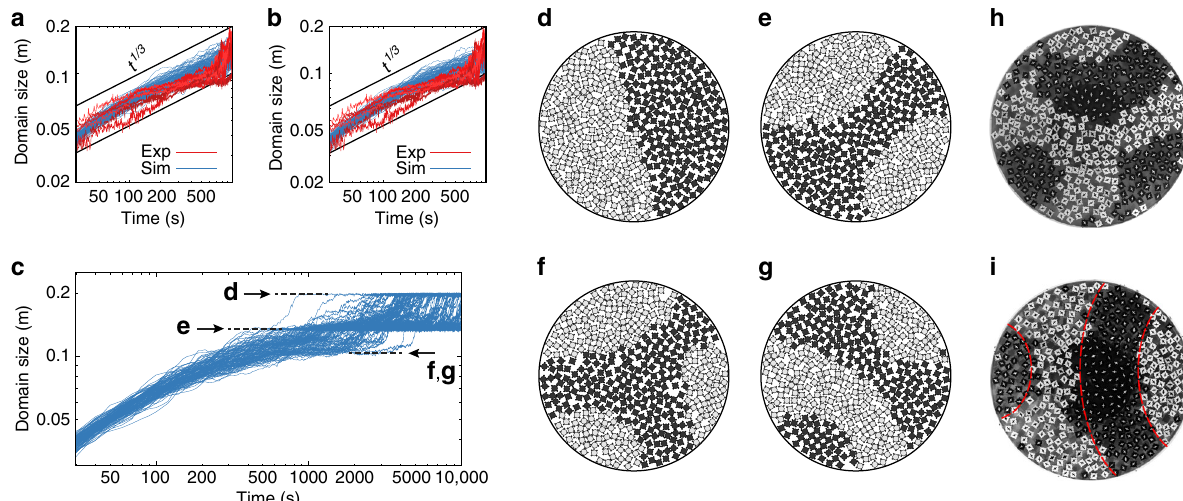
Fig. 6 Evolution of the domain size during phase separation. a , b Domain size growth at intermediate times when the effect of con fi nement is weak. The data for seven experiments (red) and 128 simulations (blue) using parameters from Table 1 ( a ) and with D T = D R = t vis = 0 ( b ) are shown. The evolution is compatible with a power-law t 1/3 . c At longer times, domain size growth develops plateaus, which correspond to high-symmetry metastable states. d – g We typically observe the fi nal Janus state ( d ), a three-domain state with mirror symmetry ( e ), and four-domain states with three-fold rotational symmetry ( f ) and a stripe geometry ( g ). h , i Symmetric states from the experiment after 690 s and 960 s, respectively, with nearly three-fold and twofold symmetry. Interfaces (dashed lines) tend to intersect the boundary at angles close to 90°. Corresponding domain sizes are indicated with arrows in c . For further visualizations of the development of metastable states during phase separation, see Supplementary Fig. 5 – 6 and Supplementary Movies 5, 6